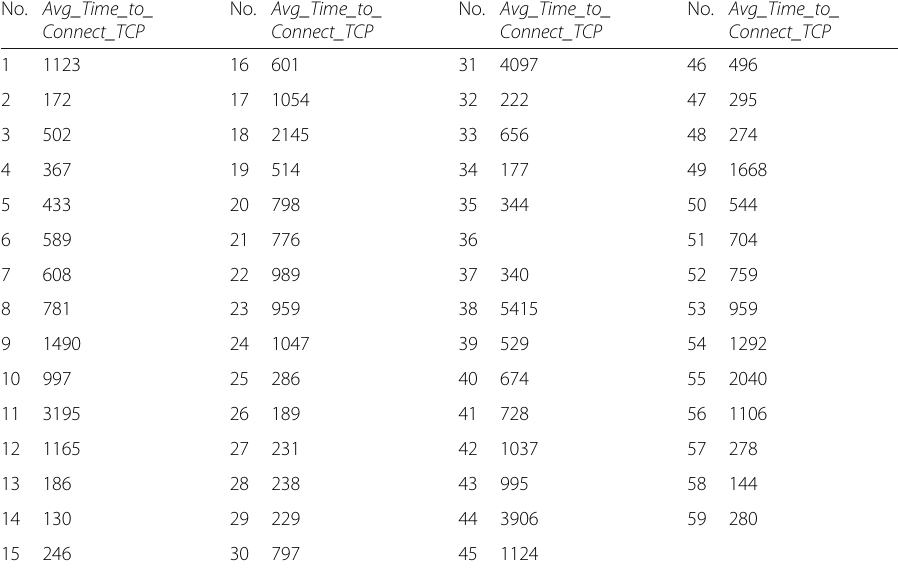
Table 2 Independent predicting variable Average-Time-to-Connect-TCP (ms), in-service measured at the Gn interface